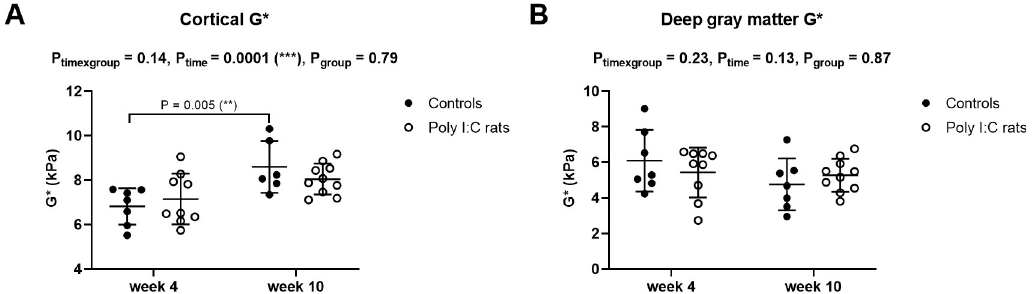
Fig 7. Shear modulus (G � )(mean ± standard deviation) of the cortex (A) and deep gray matter (B), measured at 800Hz in controls (•) and poly (I:C) rats ( � ) at weeks 4 and 10 after birth. Cortical G � increased from week 4 to week 10 only in control rats. Data were analyzed with a mixed-effects model with Sidak’s multiple comparisons. P values for significant Sidak’s comparisons are